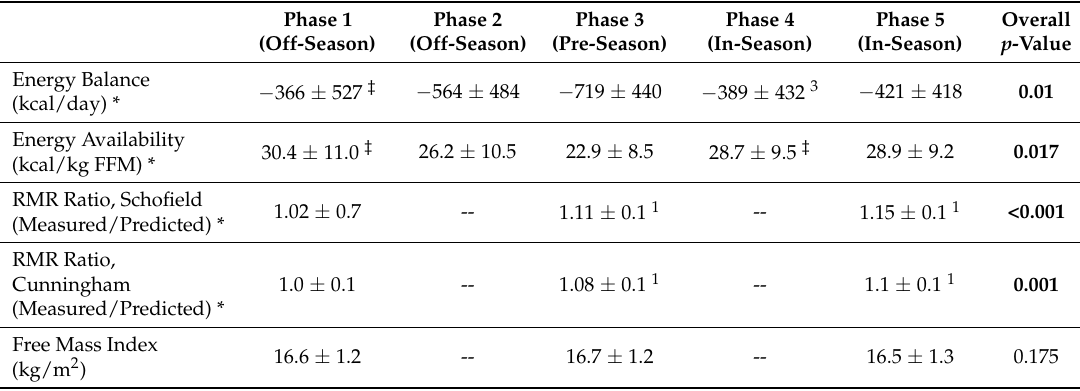
Table 4. Energy Balance, Energy Availability and Surrogate Markers of Energy